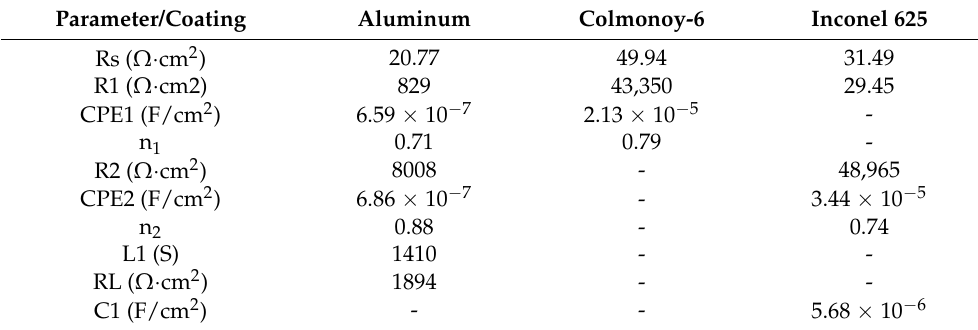
Table 6. Impedance parameters results calculated for all coatings at 60 ◦